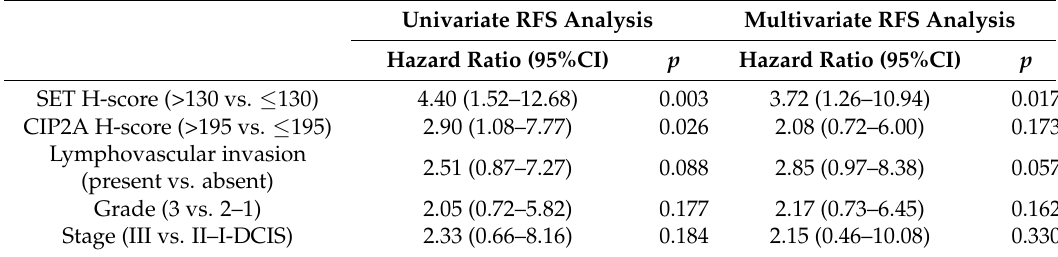
Table 2. Univariate and multivariate Cox analysis of factors associated with recurrence-free survival (RFS) in ER-positive breast cancer patients receiving the tamoxifen treatment.